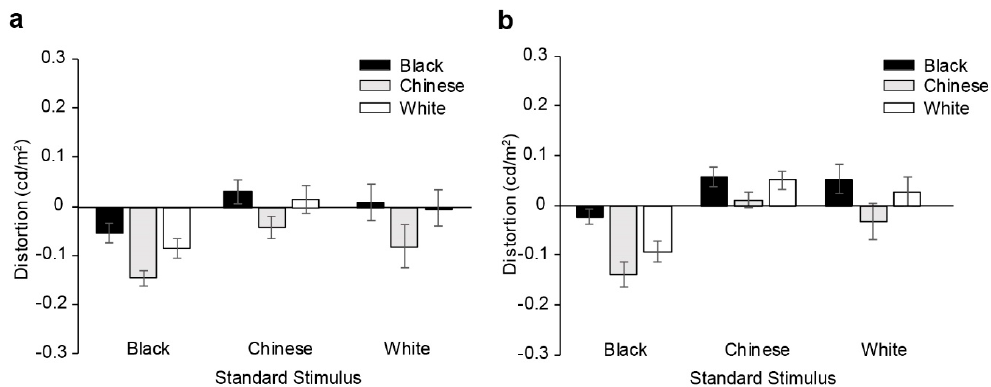
Figure 2. Matching errors for the face task, across all combinations of same- and different standard/variable contexts (races), presented independently for the ( a ) Chinese, and ( b ) White observers. Negative and positive error values reflect final estimations of a variable stimulus that were darker or lighter than the luminance of the standard stimulus, respectively. Error bars represent ± standard error of the mean.